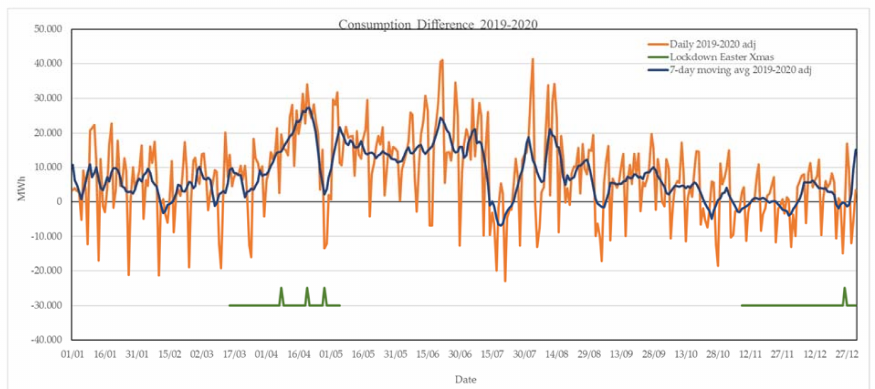
Figure 4. Reduction in daily electricity demand in the mainland grid (in MWh) in 2020, adjusted for temperature, from that og 2019 including 7-day moving average values (blue). The Easter holiday and lockdown periods are also indicated (Green).